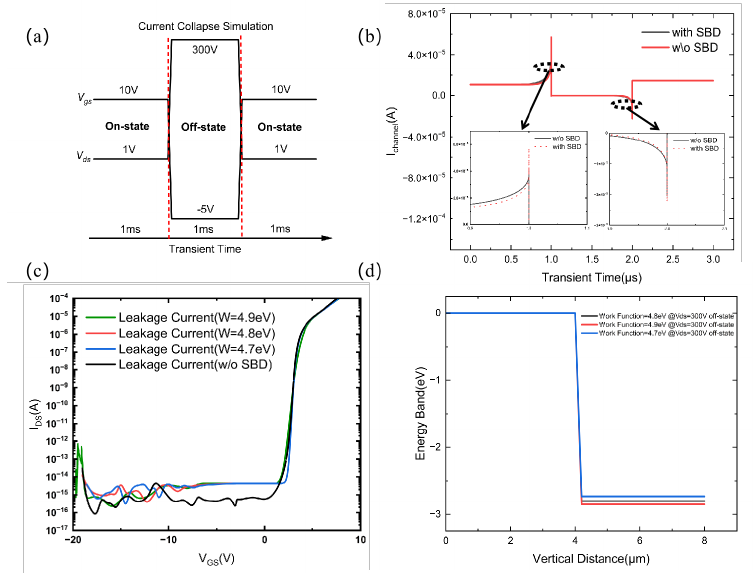
Figure 3. ( a ) Timings and parameter settings in the current collapse simulation; ( b ) Current collapse results; ( c ) Leakage current under DUTs test; ( d ) Conduction band energy of SiC TED MOS with distinct work